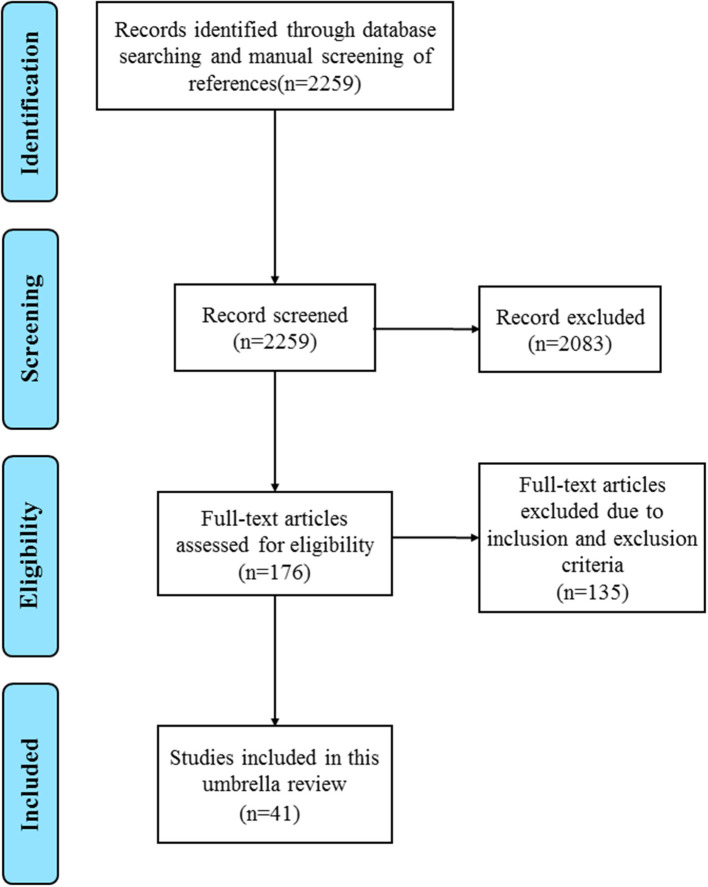
The flow diagram of the study selection.